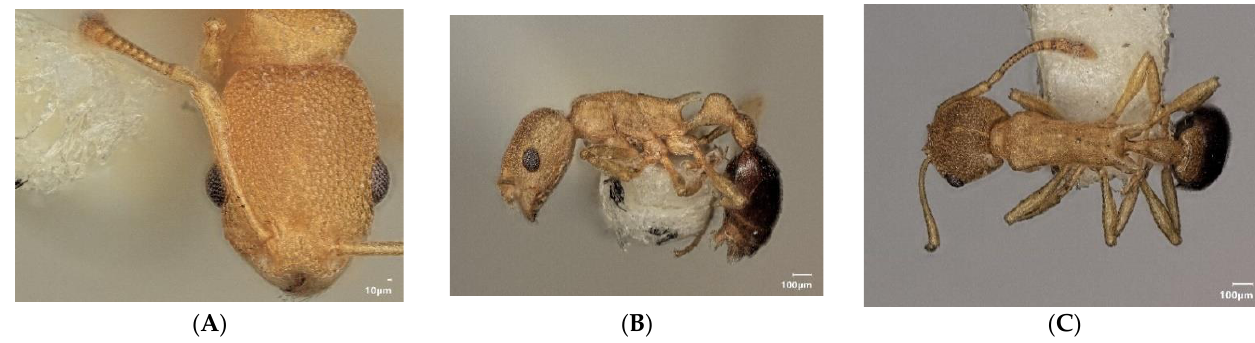
( C ) Figure 20. Cardiocondyla goroka n.sp., paratype: head in dorsal view ( A ), lateral view ( B ), dorsal view ( C ). ( A ) ( C ) Figure 21. Cardiocondyla nigrocerea : head in dorsal view: ( A ), lateral view ( B ), dorsal view ( C ).